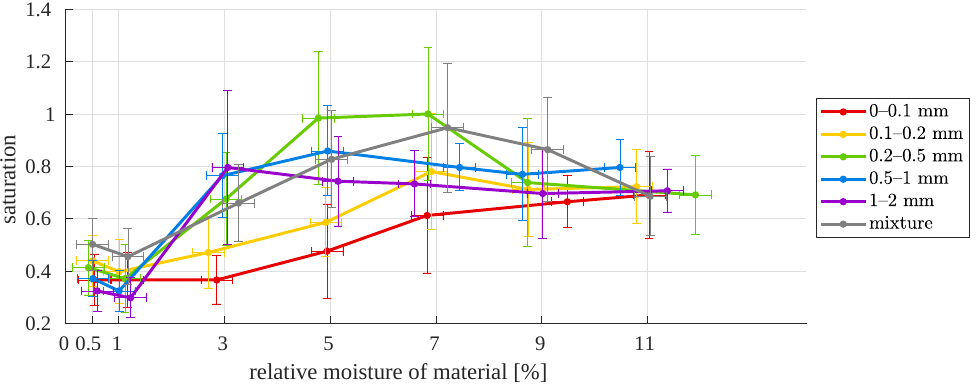
Figure 22. Image median saturation as function of relative moisture, for different particle sizes.